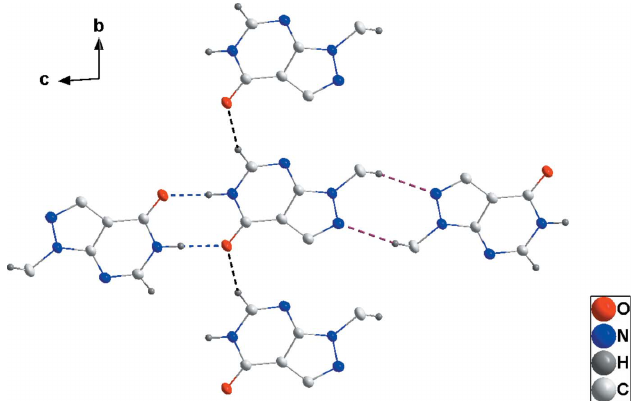
Figure 2 Detail of the hydrogen-bonding network viewed along the a